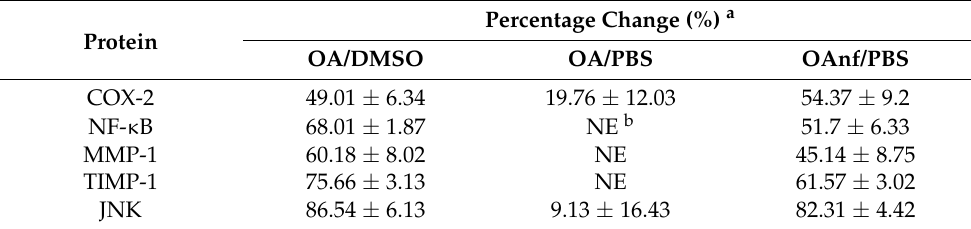
Table 4. The percentage change of protein expression from OA and OAnf in PM-induced HaCaT cell